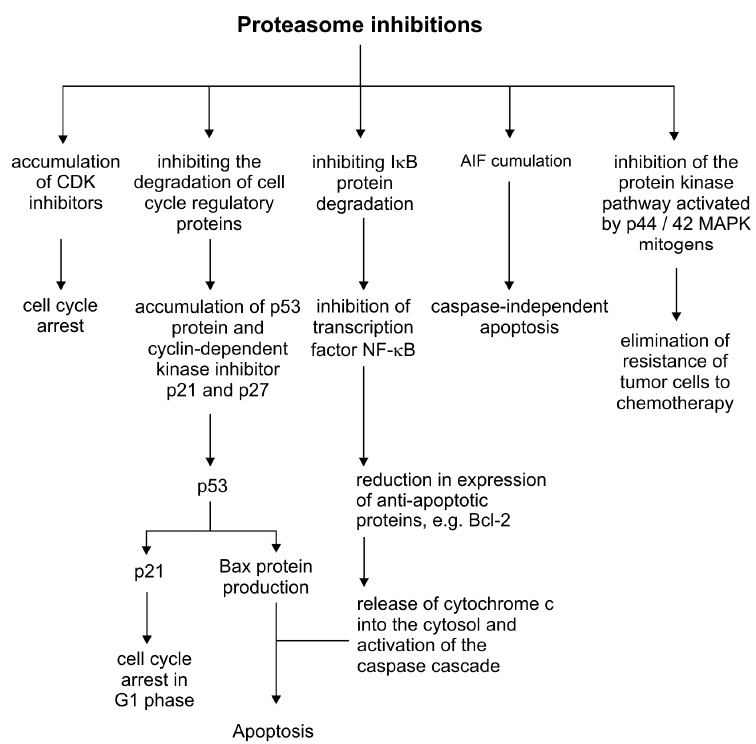
Figure 3. Inhibition of the proteasome in the regulation of cellular processes.